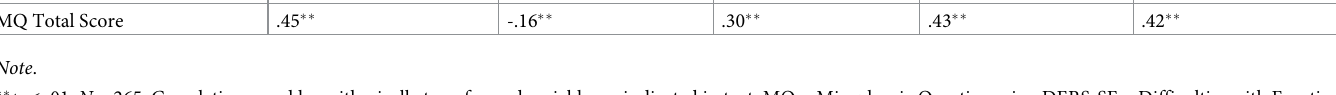
Regulation Scale Short Form; ALS-18 = Affective Lability Scale; CEFIS = COVID-19 Exposure and Family Impact Survey; GAD-7 = Generalized Anxiety Disorder 7-Item Scale; PHQ-9 = Patient Health